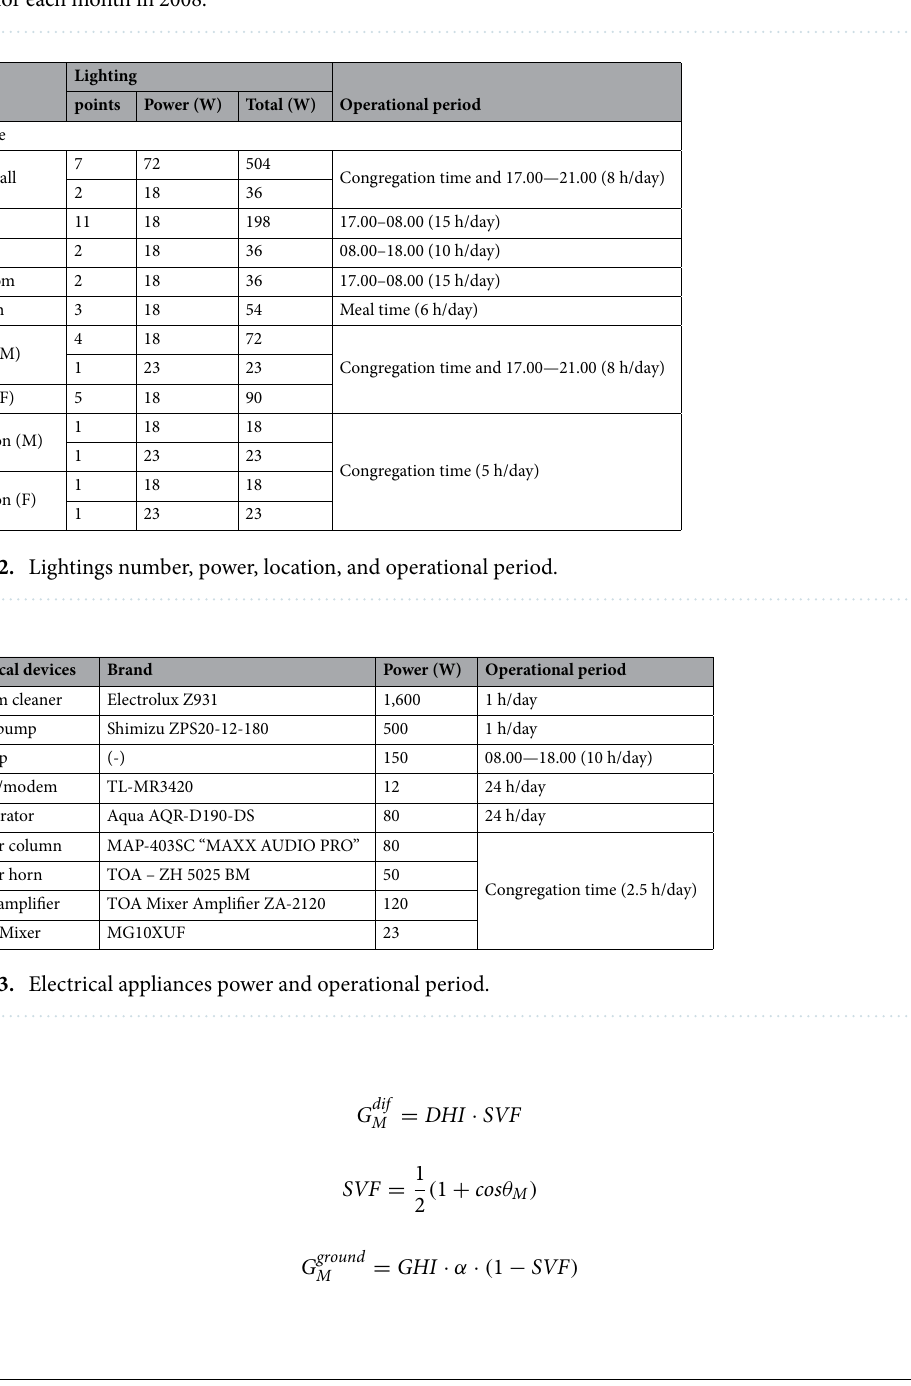
Figure 2. ( a ) average daily GHI at each year between 2008–2019. ( b ) Average daily irradiance (DHI, DNI, and GHI) for each month in 2008.